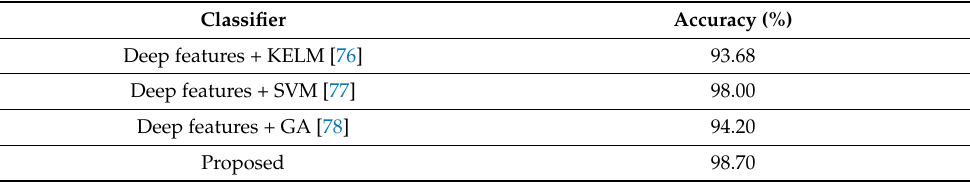
Table 5. Comparison with ML-based